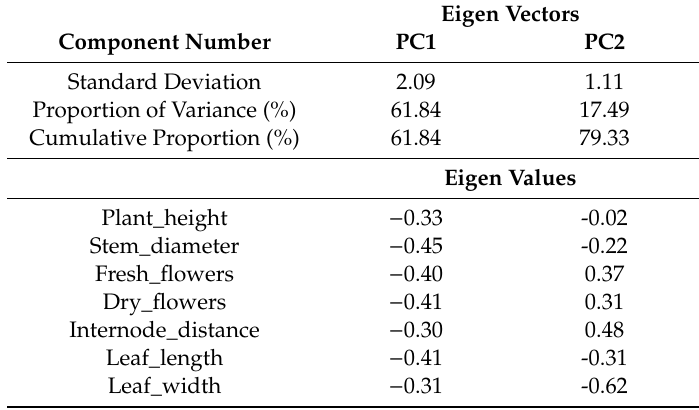
Figure 3. Principal component analysis plot showing different haplotypes for 378 Phragmites plants based of seven phenotypic traits. Table 3. Principal component analysis of seven Phragmites australis